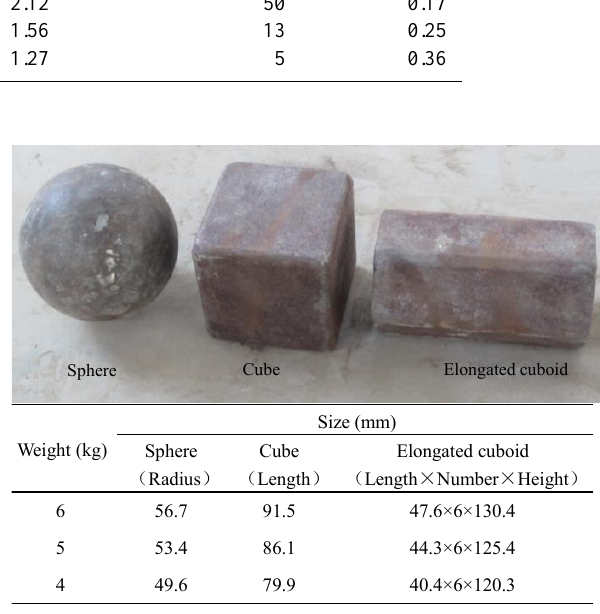
Figure 4. Shapes and sizes of the falling specimens. Table 2. Test